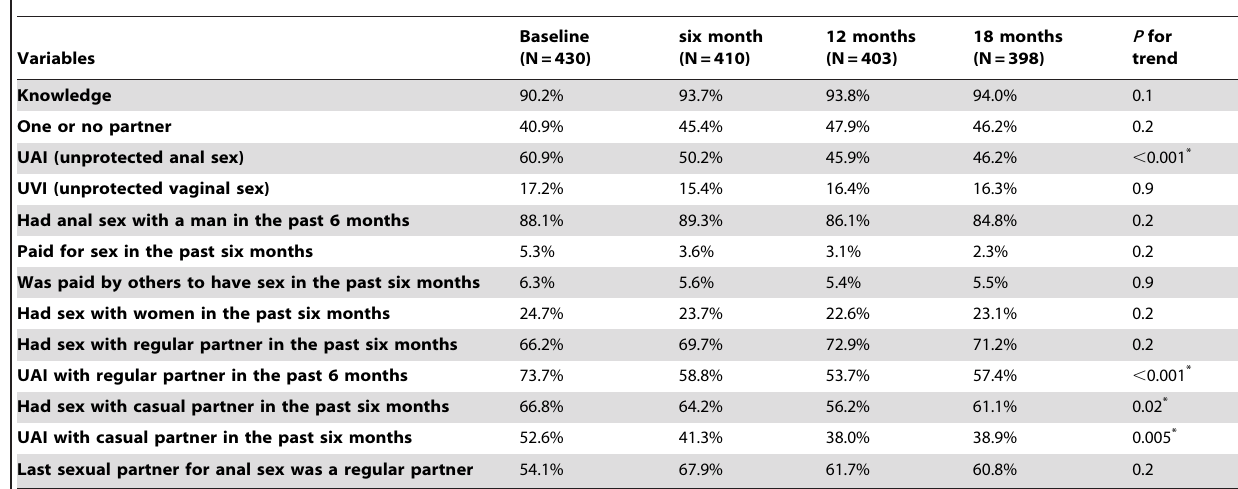
Table 4. The trend of HIV-related knowledge and reported risk behaviors after imputation in Nanjing, China,